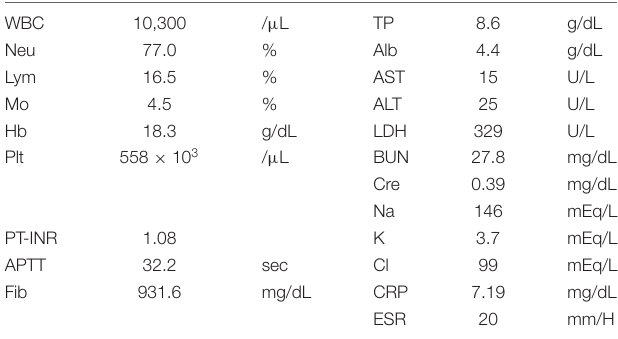
TABLE 2 | Blood test and biochemical test results at the second